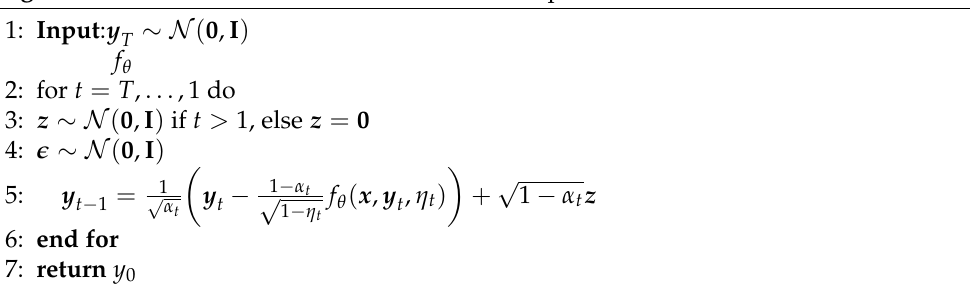
Algorithm 2 Inference in T iterative refinement